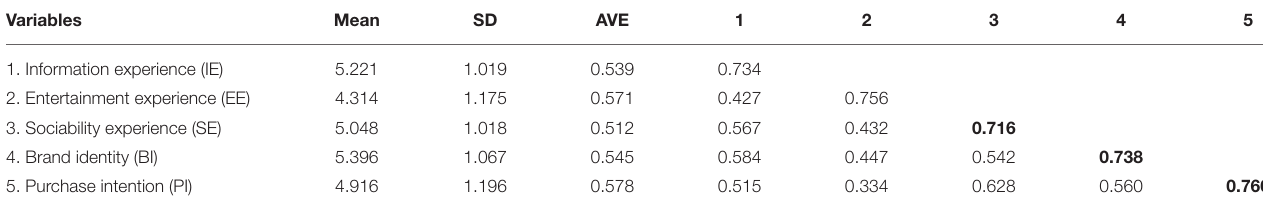
TABLE 3 | Discriminant validity for the measurement